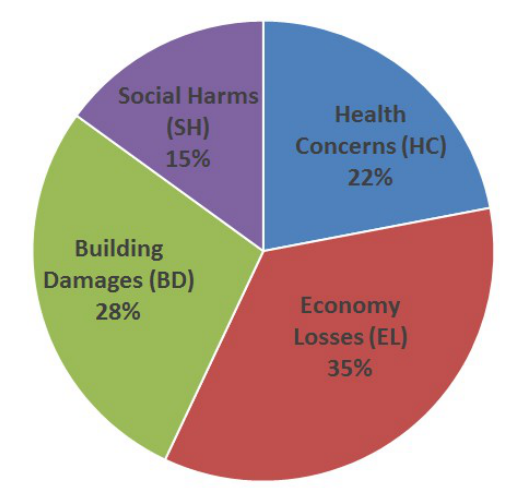
Figure 10: Distribution of different types of SBV/SBN